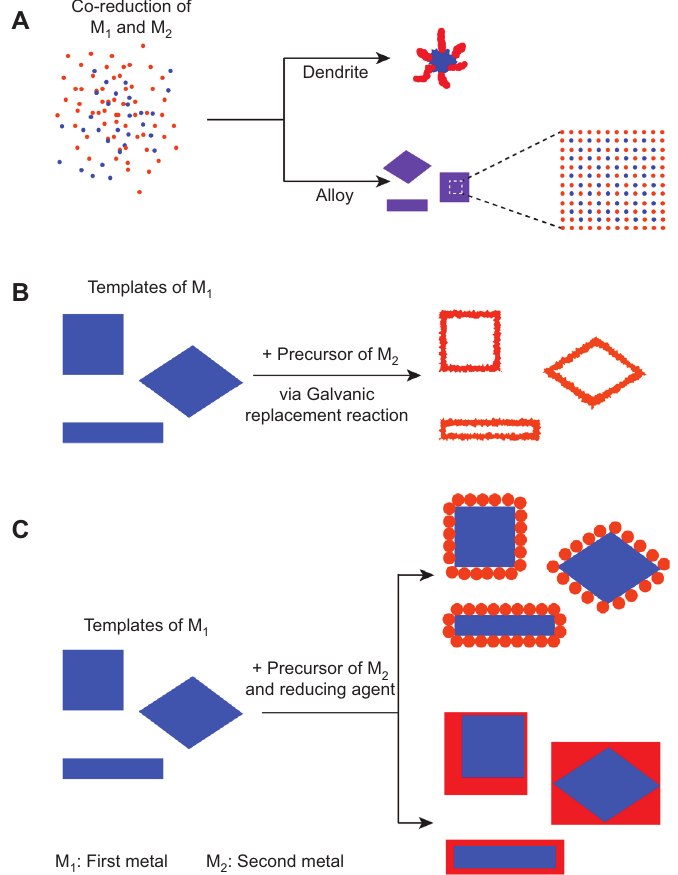
Figure 2 Synthetic approaches for bimetallic nanostructures with controlled shapes. (A) Co-reduction method to form dendritic core-shells or alloyed nanocrystals with polyhedral shapes. (B) Galvanic replacement reaction (GRR) method to form porous hollow bimetallic nano- structures. (C) Seeded growth for the formation of core-shell nanostructures. Depending on the amount of the precursor and the deposition mode of the second metal, it may form a conformal thin layer coating, thick shell, or nanoparticle array on the surface of the first